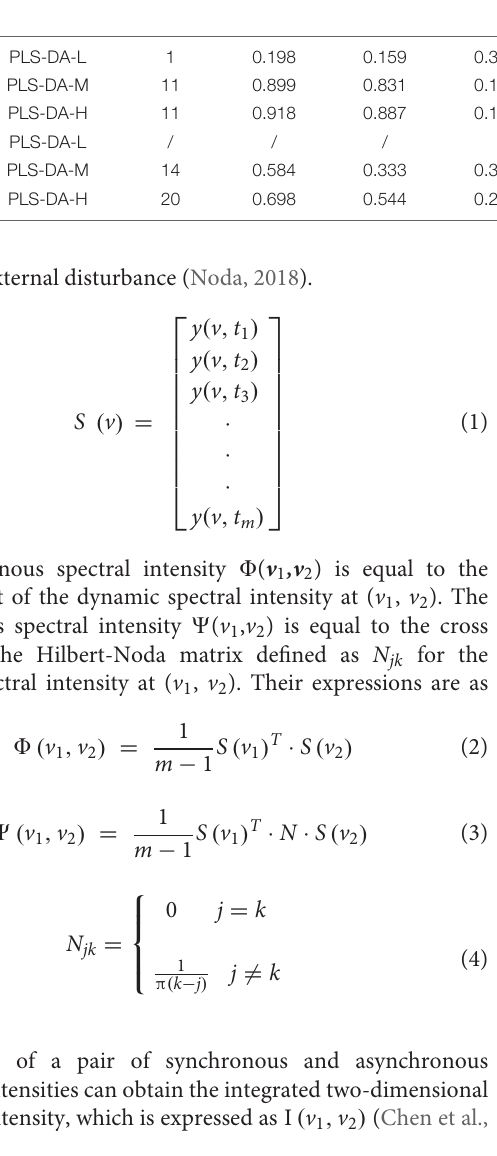
Training set Test set